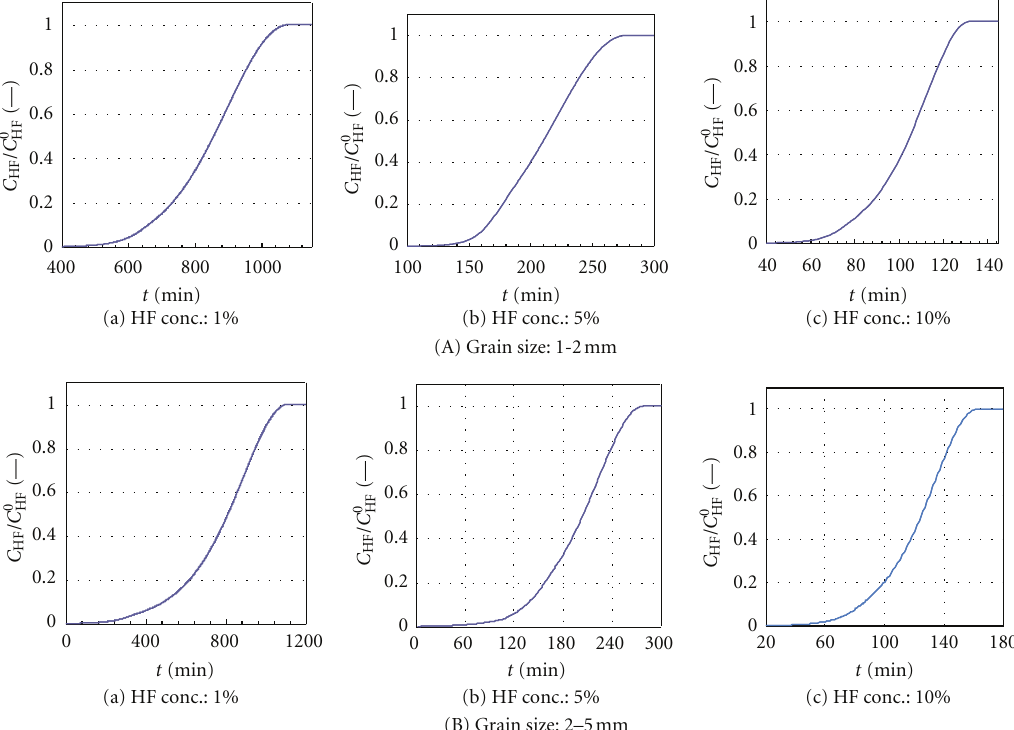
Figure 7: HF breakthrough properties of CaCO 3